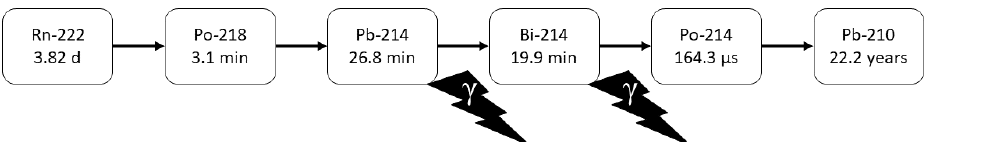
Figure 2. Short-lived progeny of radon-222 and their half-lives. Lead-214 and bismuth-214 are significant gamma emitters at the time of their decay.